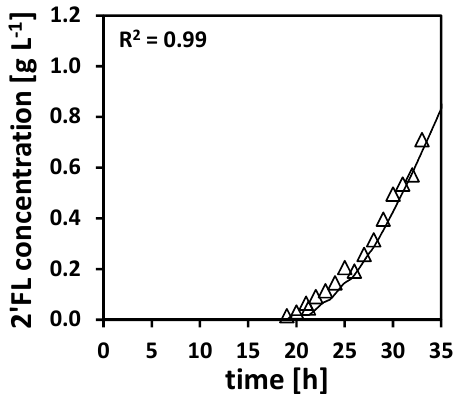
Figure 10. Time course of the product concentration 2 ′ -FL for fed-batch 4: symbols mark the measured product concentration, the line marks adapted simulated cultivation course for the product (Model D). For the parameter estimation results, see Tables A20–A22. For model equations, see Table A19 or